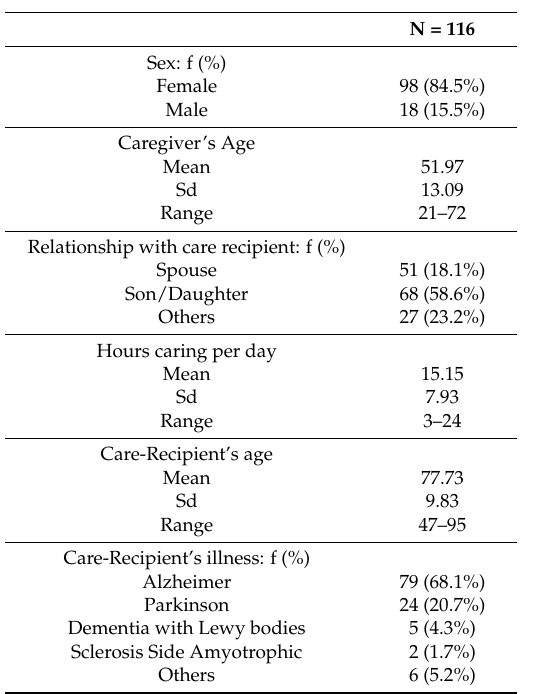
Table 1. Sociodemographic data of the